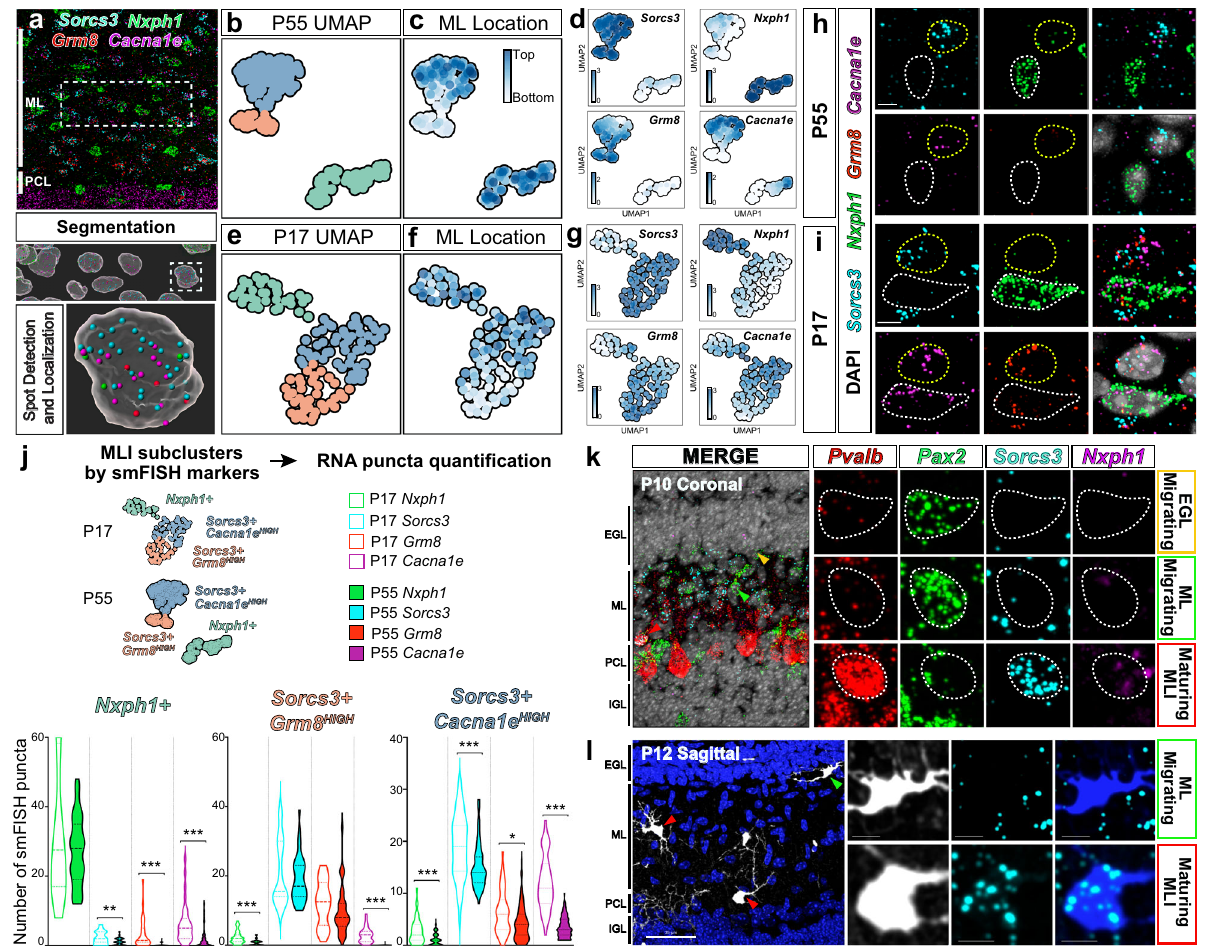
Fig. 6 Spatial-temporal analysis of markers show that MLI t-type identities appear late in development. a Top, four-color smFISH image for MLI t-type markers Sorcs3, Nxph1, Grm8 , and Cacna1e , in cerebellar cortex. Bottom, single-cell smFISH spot quanti fi cation for each transcript within segmented cell boundaries. b UMAP clustering using smFISH RNA data for 232 P55 MLIs. c Projection of ML locations, and d transcript levels for each cell onto the P55 UMAP plot. The Sorcs3 + cluster contains two domains: cells within the orange subcluster are located in the lower ML and express high Grm8 ; cells in the blue subcluster are enriched within the mid-upper ML and show graded Grm8 and Cacna1e . Cells within the green cluster are located lower-mid to high ML and express Nxph1 . e UMAP clustering using smFISH RNA data for 126 P17 MLIs. f ML locations, and g transcript levels for each cell projected onto the P17 UMAP manifold. h Representative smFISH image for P55 MLIs showing Sorcs3 (cyan) and Cacna1e (right, magenta), and another with Nxph1 (green). i smFISH image for P17 MLIs showing co-expression of Cacna1e and Grm8 (top cell, red), and co-expression of Nxph1, Grm8 , and Cacna1e (bottom cell). j Violin plot summarizing the transcript levels of individual markers within each smFISH-marker-de fi ned subcluster for P17 (un fi lled bars) and P55 data ( fi lled bars). Images and quanti fi cations for P17 data are: n = 126 cells, two animals; P55 data: 232 cells, two animals. Nxph1 + t-type: p = 0.0004 (P17 vs. P55 Sorcs3 expression); p < 0.00001 ( Grm8 ); p <0.00001 ( Cacna1e ). Sorcs3 + ; Grm8 HIGH t-type: p = 0.000022 ( Nxph1 ); p <0.00001 ( Cacna1e ). Sorcs3 + ; Cacna1e HIGH t-type: p < 0.00001 ( Nxph1 ); 0.000045 ( Sorcs3 ); 0.0012 ( Grm8 ); <0.00001 ( Cacna1e ). Means of two groups were compared using the two-tailed Mann-Whitney nonparametric test. k smFISH image of P10 coronal cerebellum for both MLI t-type markers ( Sorcs3 in cyan, Nxph1 in magenta) and maturity markers ( Pvalb in green, Pax2 in red). Sorcs3 and Nxph1 RNA are absent within migratory Pax2 + MLIs, but are expressed within post-migratory Pvalb + cells. l morFISH con fi rms that Sorcs3 is not observed within cells with migratory morphology ( N = 2 animals). Scale bars are 5 µ m in h and i , 35 µ m in k and l